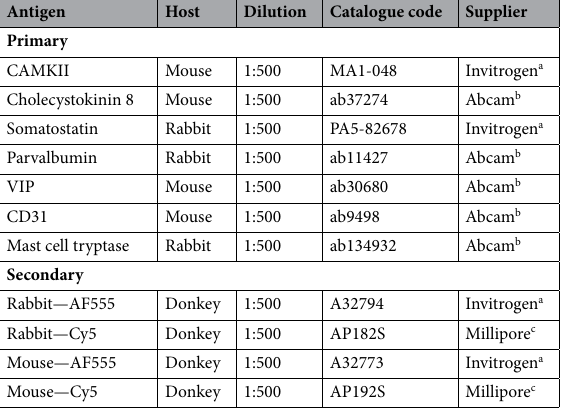
Table 1. Primary and secondary antibodies used in the study. CAMKII—CaM kinase II; VIP – Vasoactive Intestinal Peptide. a Thermo Fisher Scientific, Rockford, Illinois, USA. b Abcam, Cambridge, United